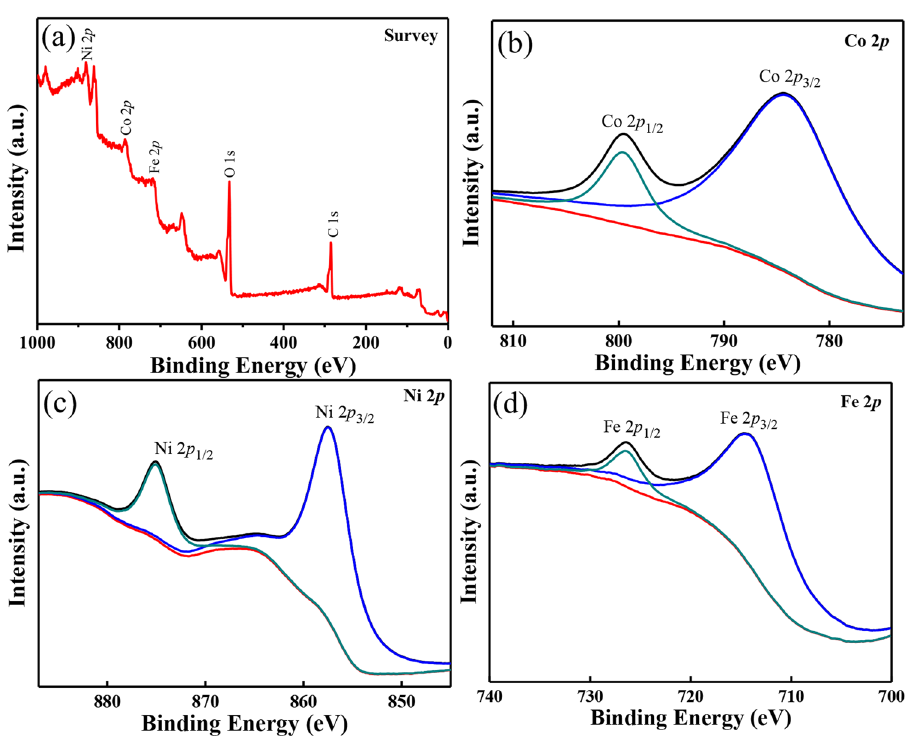
Figure 4. XPS spectra of the CoNiFe-LDH/CNFs-0.5 composite: ( a ) survey spectrum; ( b ) Co 2 p ; ( c ) Ni 2 p and ( d ) Fe 2 p